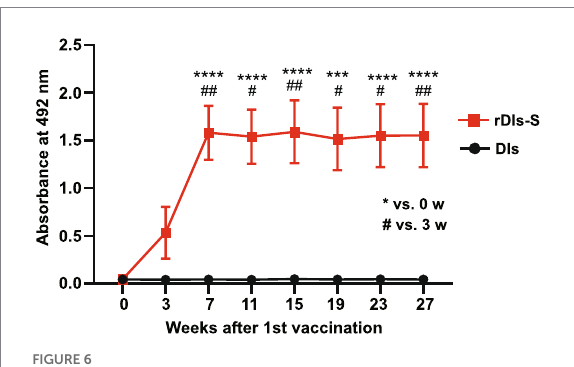
FIGURE 6 Time course of antibody responses after vaccination with rDIs-S in mice. BALB/c mice were inoculated twice intradermally with 1 × 10 8 PFU of rDIs-S or DIs with a 3-week interval. Time course of the production of IgG specific for SARS-CoV-2 S protein as measured by ELISA ( n = 12 per group). p values were calculated using a two-tailed Kruskal–Wallis test, followed by a Dunn’s multiple comparison